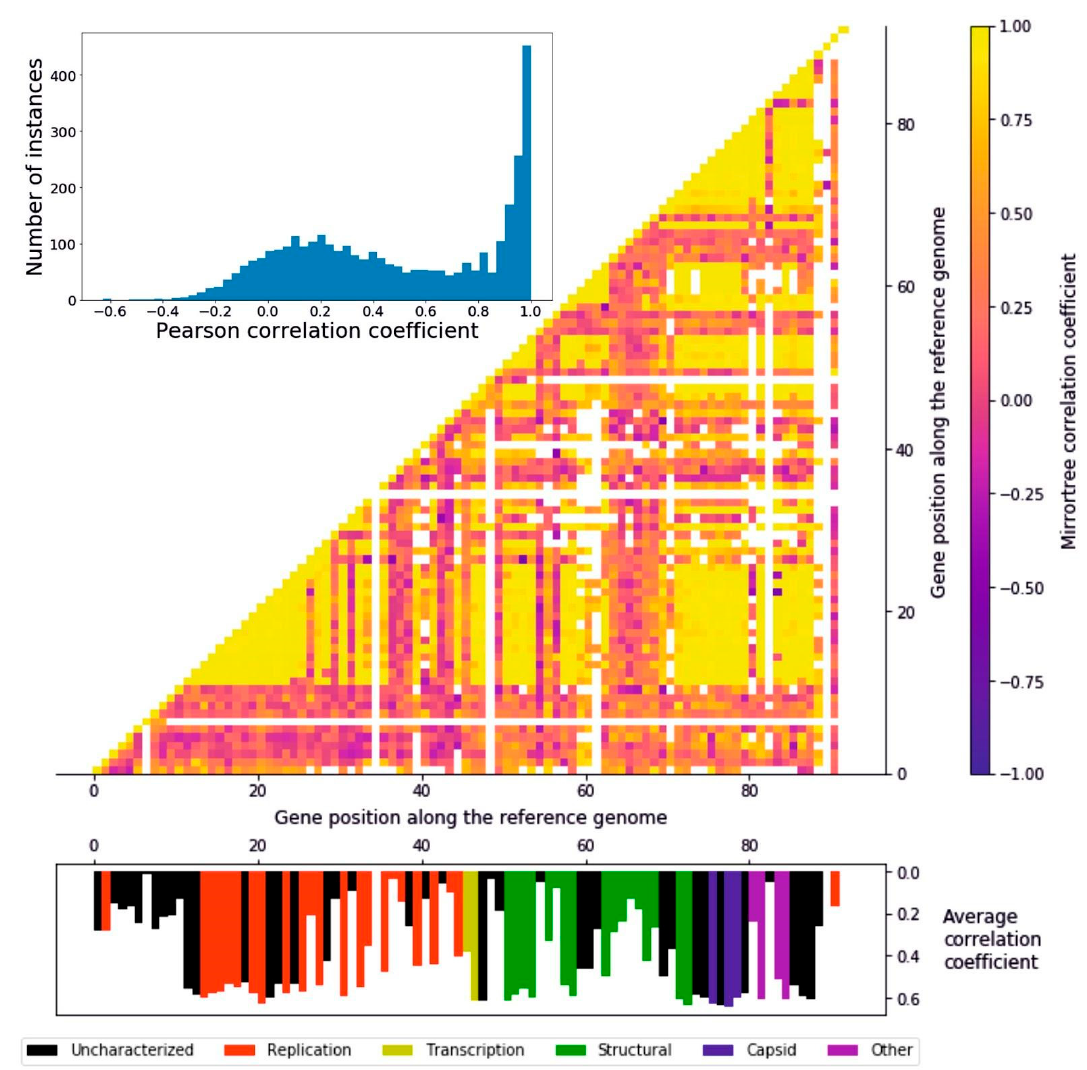
Figure 3. Mirrortree algorithm applied to the homologous groups of proteins. Histogram representing the distribution of the pairwise Pearson’s r coefficients. A great number of genes appear to be coevolving. Heatmap of the Pearson correlation coefficient of each protein with any other. Along the x and y axis the 92 ORFs identified in the reference crAssphage genome are represented. The interactions between clusters sharing less than five sequences were colored in white, in order to avoid confusion due to a low size. Histogram representing the average correlation coefficient of every protein represented in their position on the reference genome. The different colors represent the six functional groups.